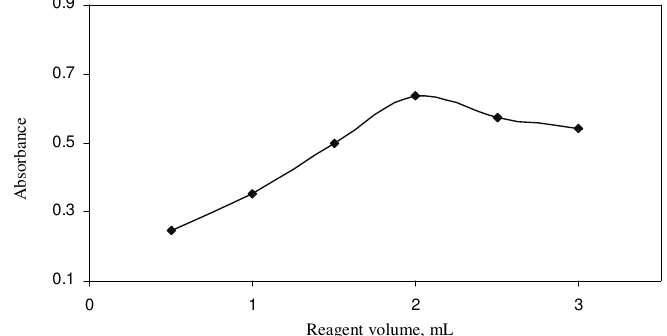
Figure 2. Effect of 0.1% cupric chloride volume on the reaction between cupric chloride and 75 µ g mL -1